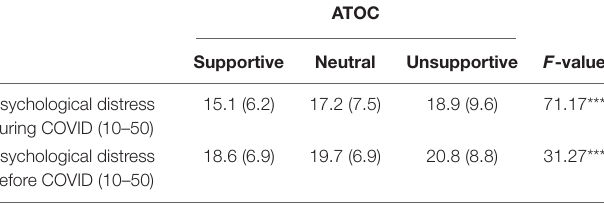
TABLE 3 | Levels of psychological distress: by